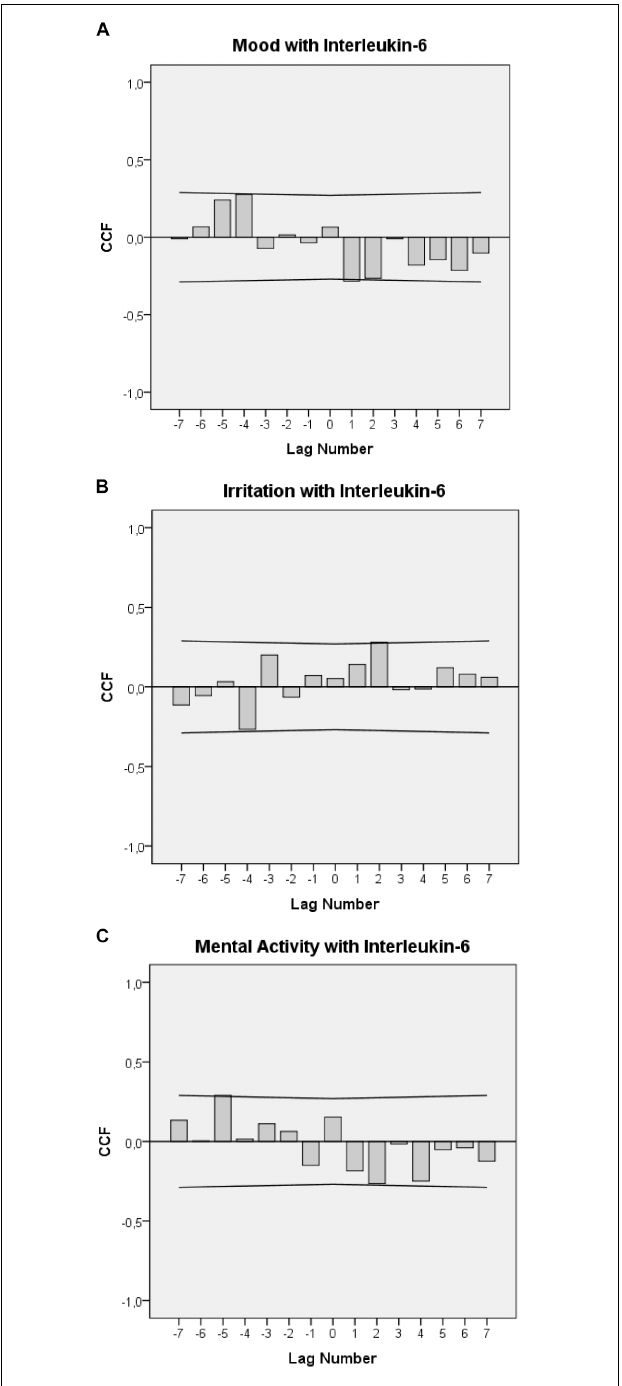
FIGURE 2 | Cross-correlation functions (CCF) between urinary IL-6 levels, mood (A) , irritation (B) , and mental activity (C) . Each lag represents a 12-h interval. Plots show cross-correlation coefficients (bars) and upper and lower limits of the 95% confidence intervals. Significance level is p < 0.05. A positive lag significance means that levels of mood, irritation, and mental activity precede IL-6 levels. A negative lag significance means that IL-6 levels precede levels of mood, irritation, and mental activity. The change in the sign of the cross-correlation functions between positive and negative lags indicates negative feedback loops (A–C)